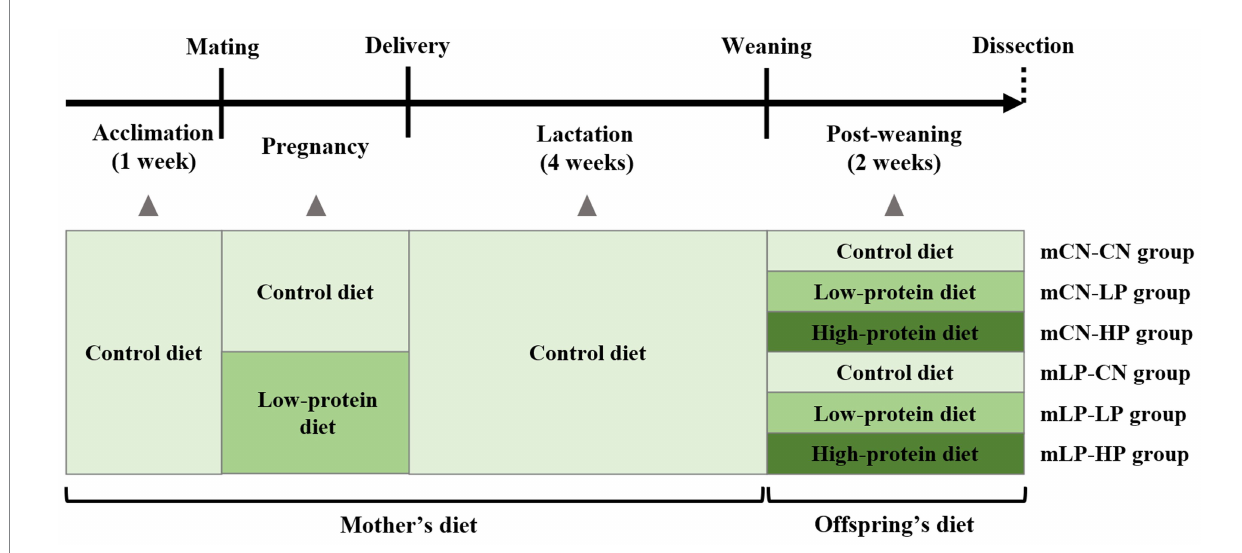
FIGURE 1 Schedule of the animal experiment. mLP-CN, maternal low-protein diet and control diet in offspring; mCN-CN, maternal control diet and control diet in offspring; mLP-LP, maternal low-protein diet and low-protein diet in offspring; mLP-HP, maternal low-protein diet and high-protein diet in